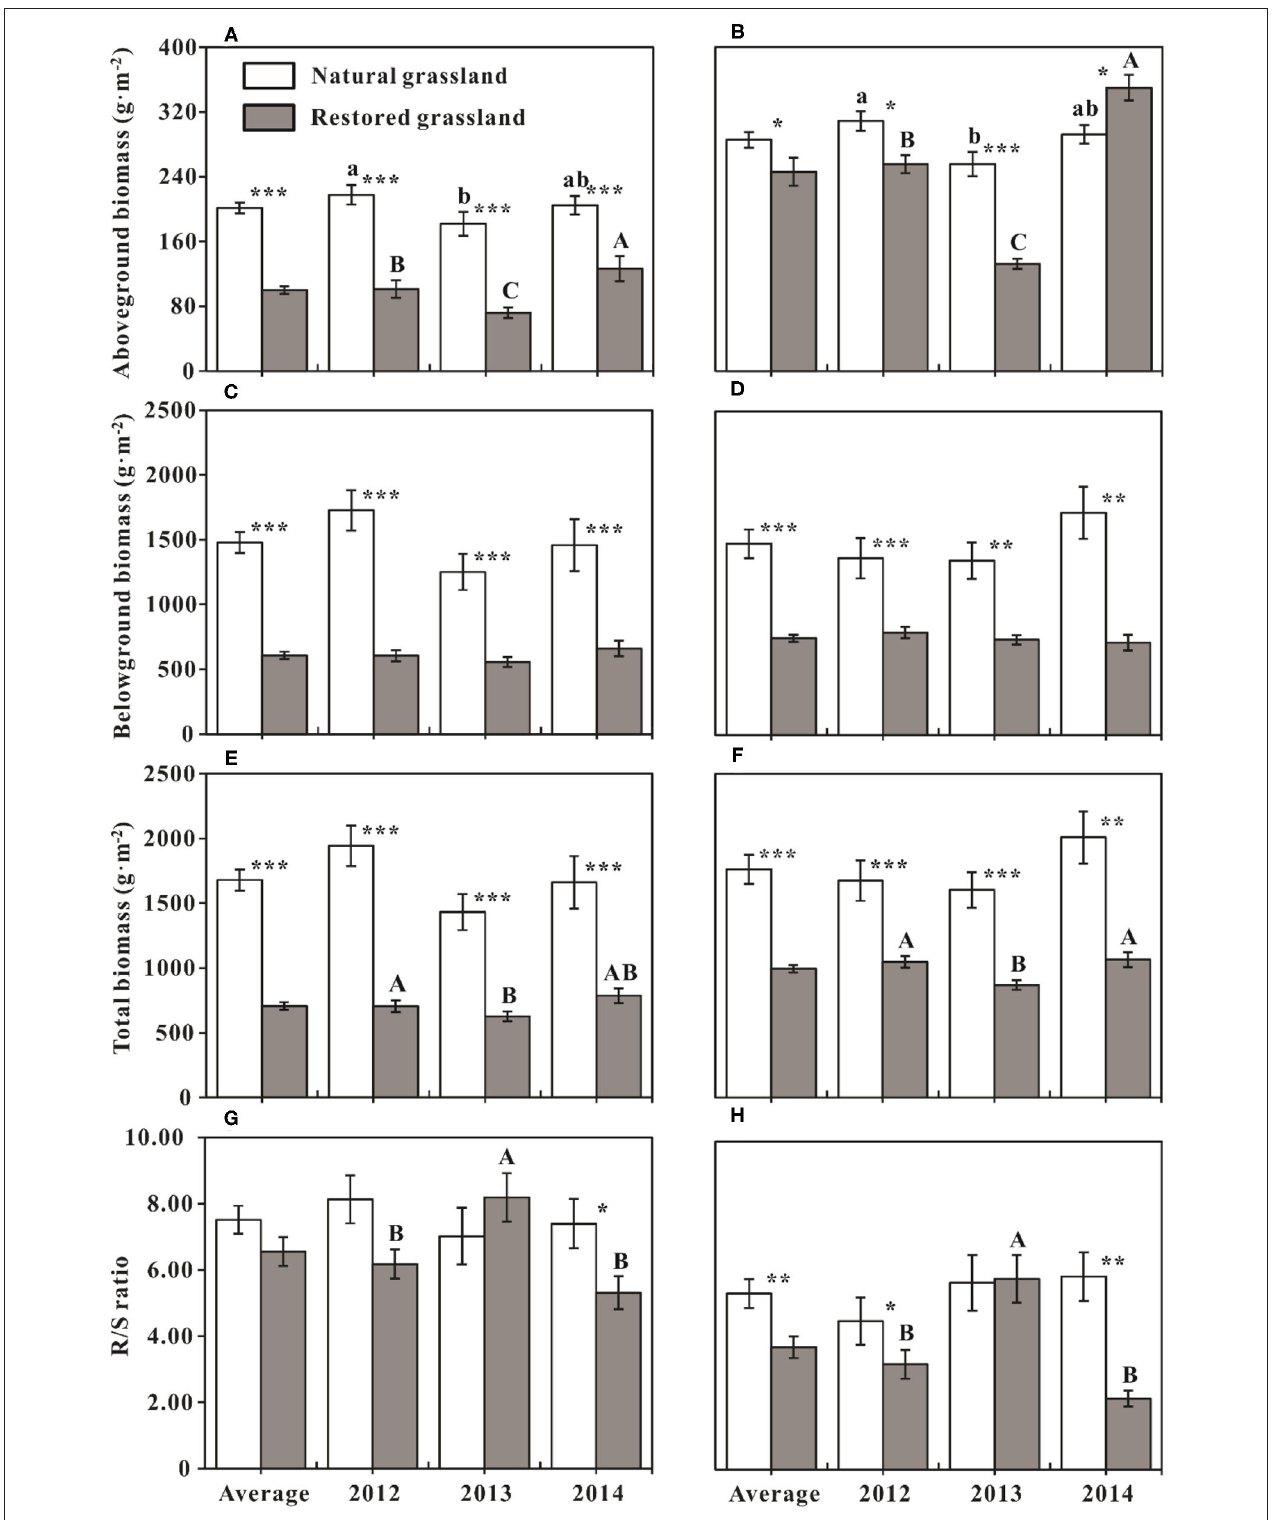
FIGURE 2 | Comparisons of biomass parameters (mean ± SE, n = 12) among sampling years in the same grassland and between the natural and restored grasslands in the same years. (A,C,E,G) Comparisons of aboveground, belowground, plant community total biomass, and the ratio of root and shoot biomass in treatments without nitrogen addition, respectively. (B,D,F,H) Comparisons of aboveground, belowground, plant community total biomass, and the ratio of root and